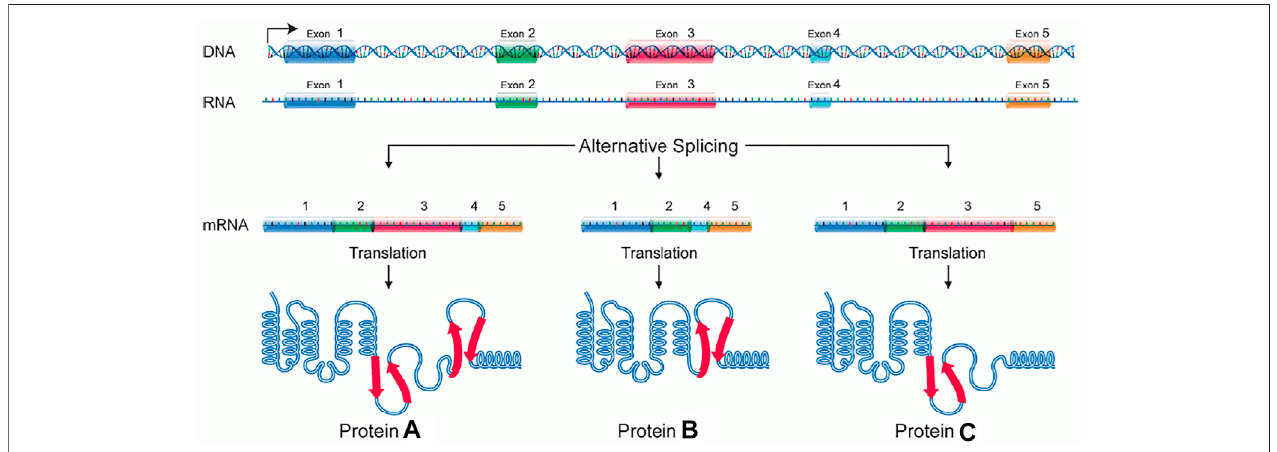
FIGURE 5 | Mechanisms of circRNA action.